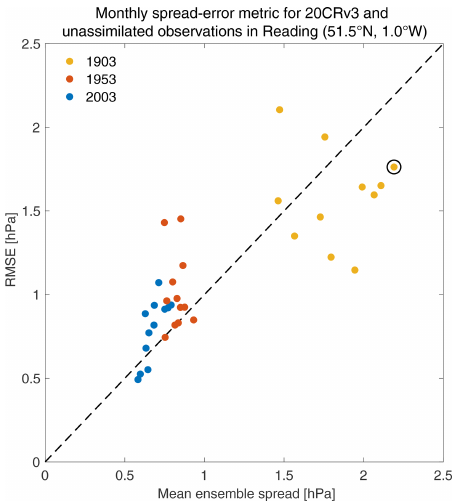
Figure B2. Ensemble reliability across years. Mean ensemble spread of the reanalysis and RMSE of the reanalysis (both in hPa) compared to unassimilated independent observations from one lo- cation where data are available for an extended period (one dot per month from three different years). For the modern period (using 1953 and 2003 examples), the ensemble is roughly reliable, so there is no evidence that the RTPS parameter needs to be altered for that time period. The open circle indicates February